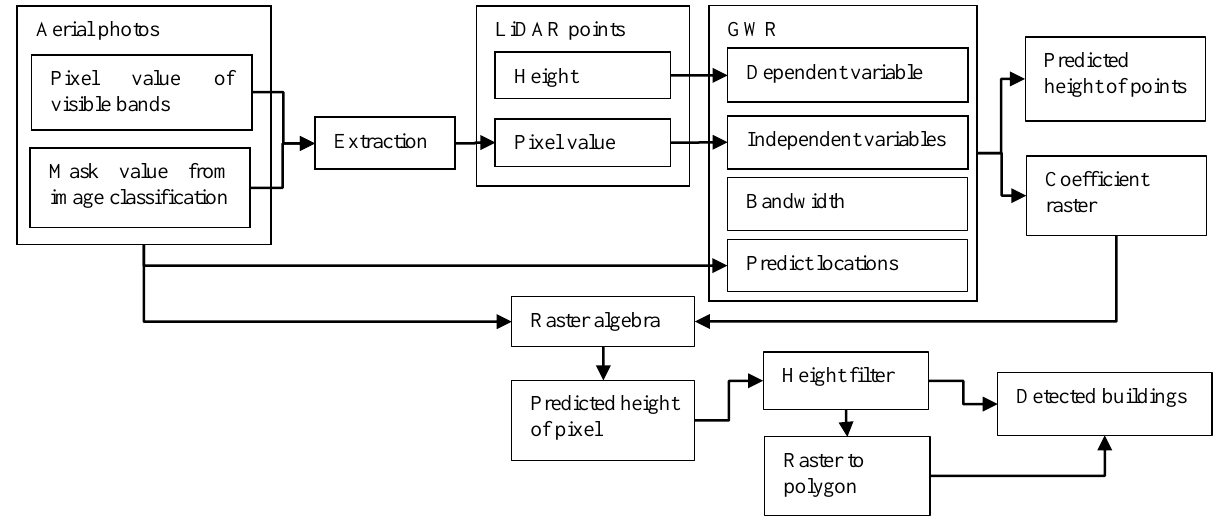
Figure 6. Flowchart of the Proposed